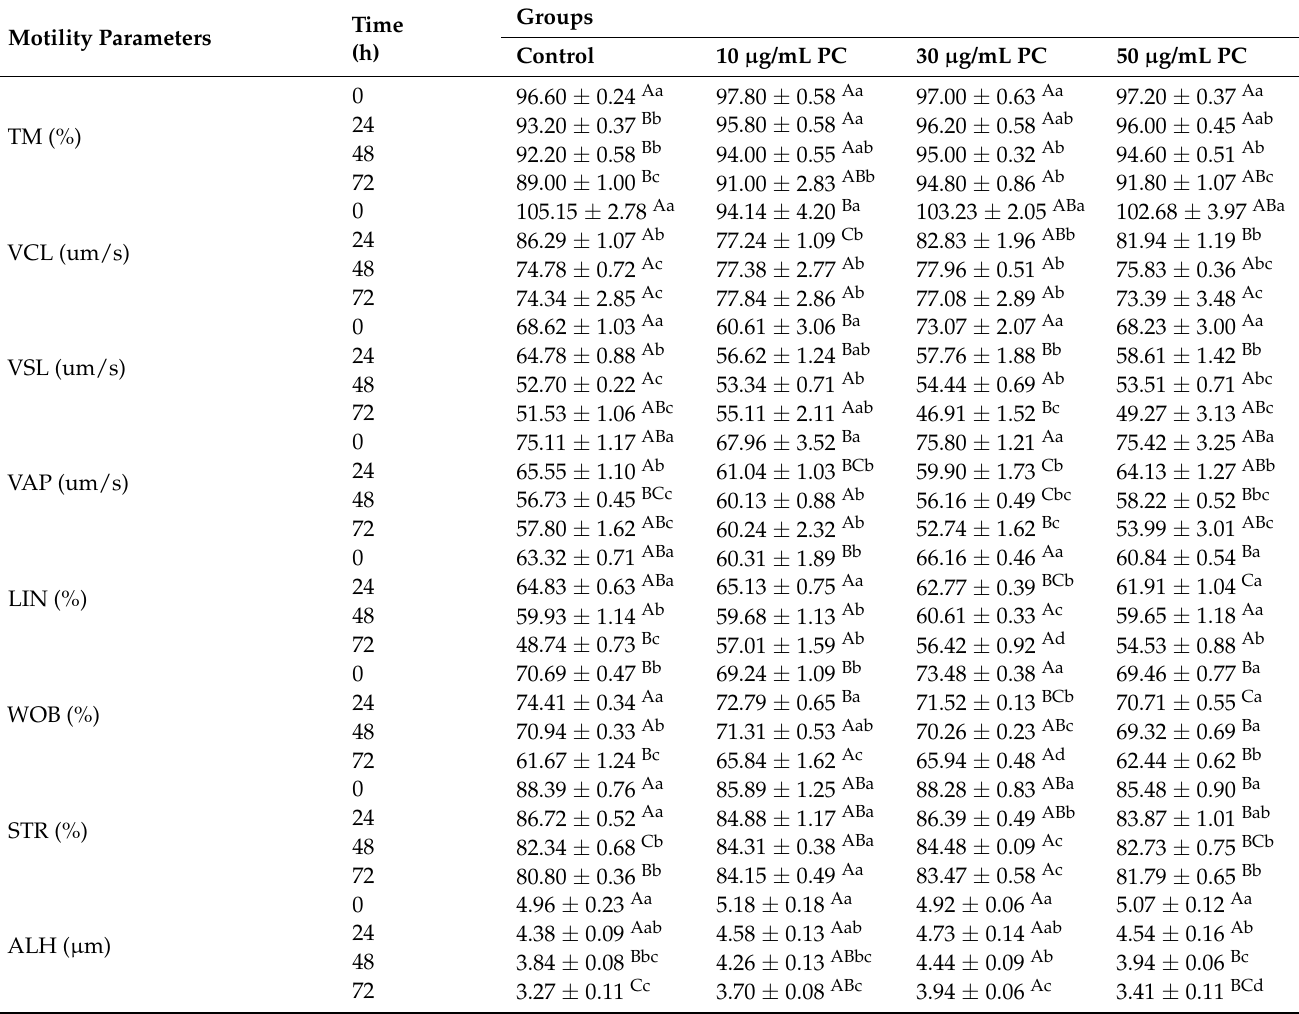
Table 2. Effects of different concentrations of procyanidin on dog sperm motility parameters after being stored at a cool temperature for 72